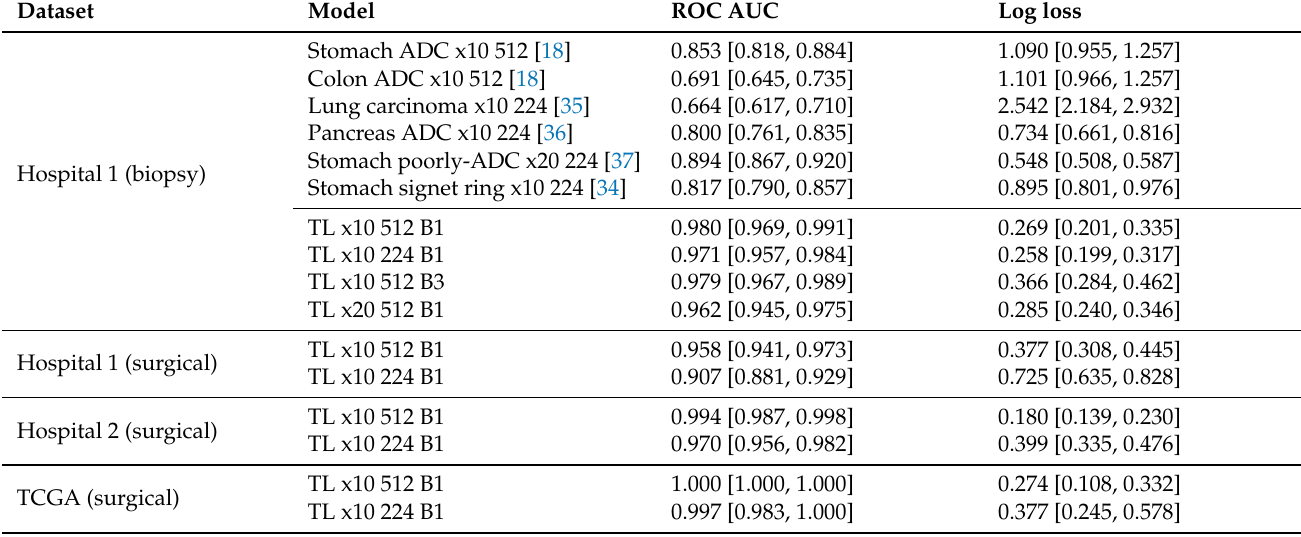
Figure 3. ROC curves on surgical test sets of the TL x10 512 B1 model. Table 2. ROC and log loss results of the models on the biopsy and surgical test sets. The trained model names are referred to as TL <magnification> <tile size> <model